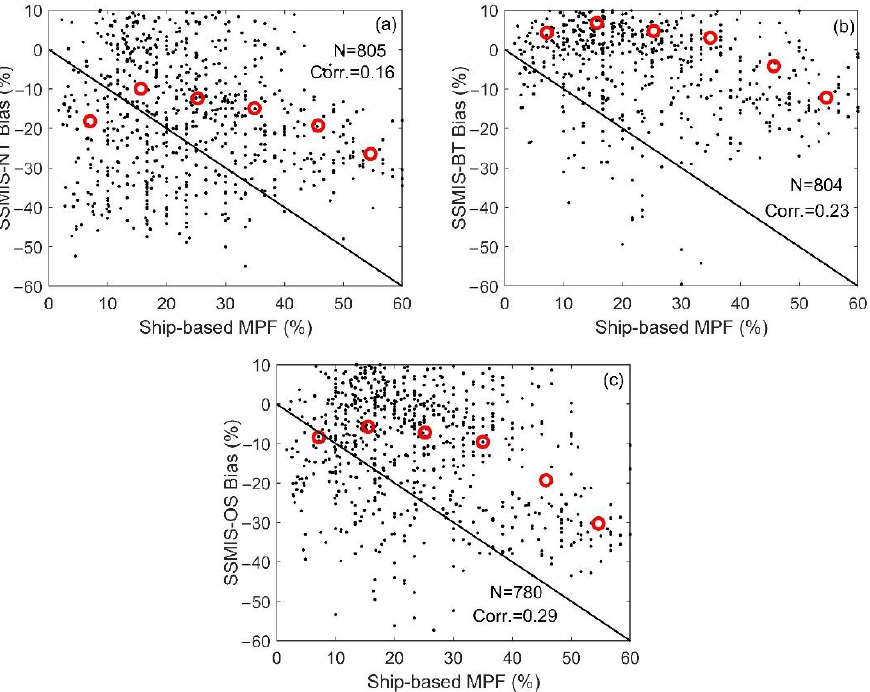
Figure 9. Scatterplots of the SSMIS-based SIC biases versus the ship-based MPFs for all the melt pond grid cells observed: ( a ) SSMIS-NT, ( b ) SSMIS-BT, and ( c ) SSMIS-OS. The black lines are 1:1 relationship lines and the red circles represent mean results for every 10% interval.